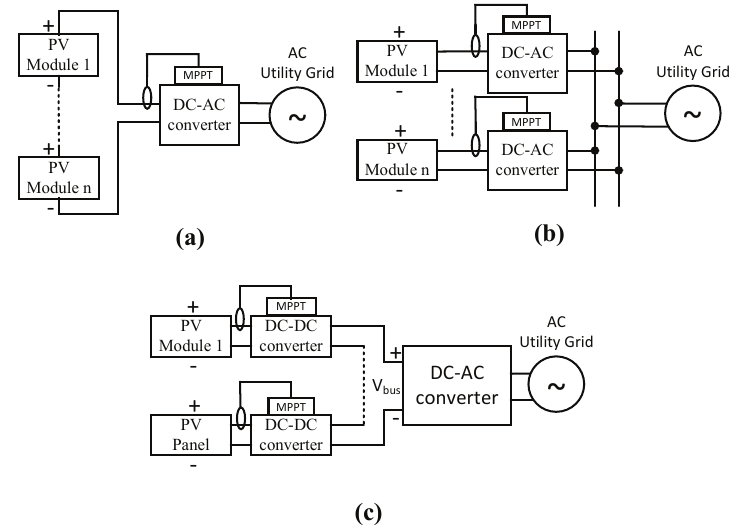
Figure 1. ( a ) series string architecture; ( b ) micro-inverter architecture; ( c ) DC–DC converter